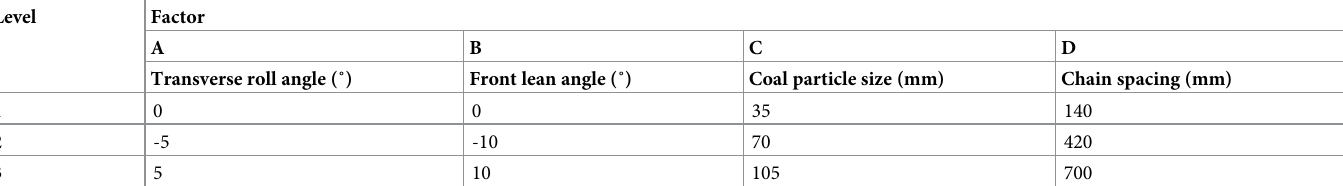
Table 3. Four factors at the three levels for impact